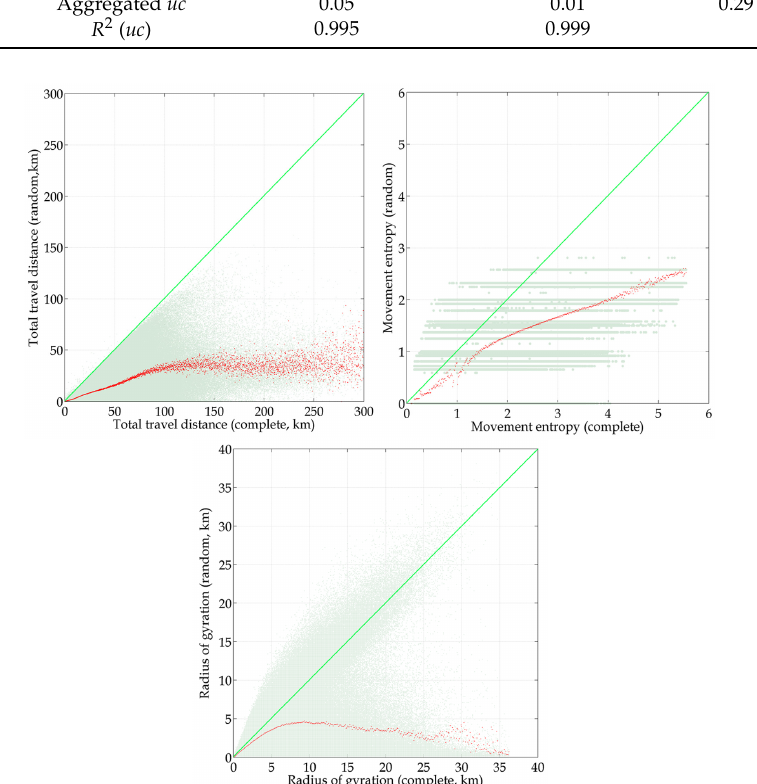
Figure 7. Human mobility indicators in 3 random segments (segment #2, #14 and #20). The light gray dots are the three random and complete mobility indicators for each subscriber. For the total travel distance and radius of gyration, the horizontal axis is 0.1 km bandwidth. For movement entropy, the horizontal axis is 0.01 bandwidth. The red dots are the average value of the gray dots in their corresponding bandwidth.